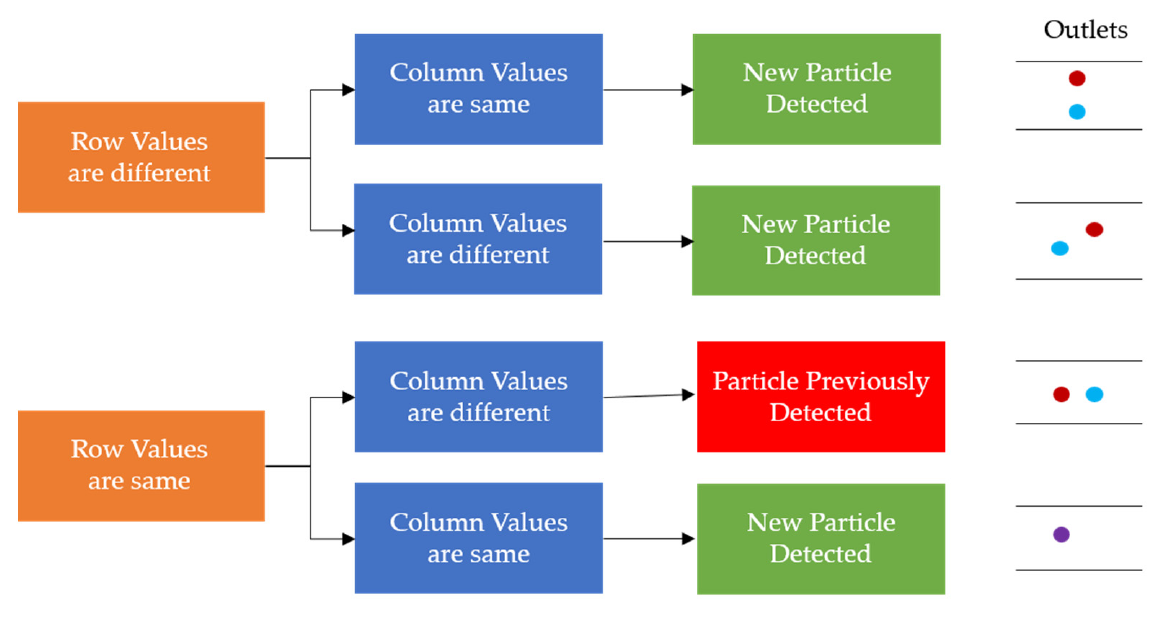
Figure 6. The rules for determining the repeat particle detection in consecutive frames based on the coordinates of the particles detected.